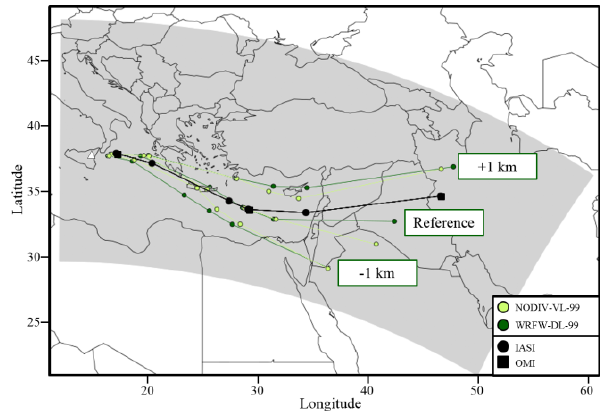
Figure 1. Satellite trajectory of the Mount Etna volcanic plume (black line) built by combining information from the IASI and OMI instruments, and the CHIMERE-simulated trajectory depending on the SO 2 injection altitude of emissions (light and dark green lines denote NODIV-VL-99 and WRFW-DL-99, respectively). The gray area represents the CHIMERE simulation domain, and the white triangle indicates Mount Etna’s